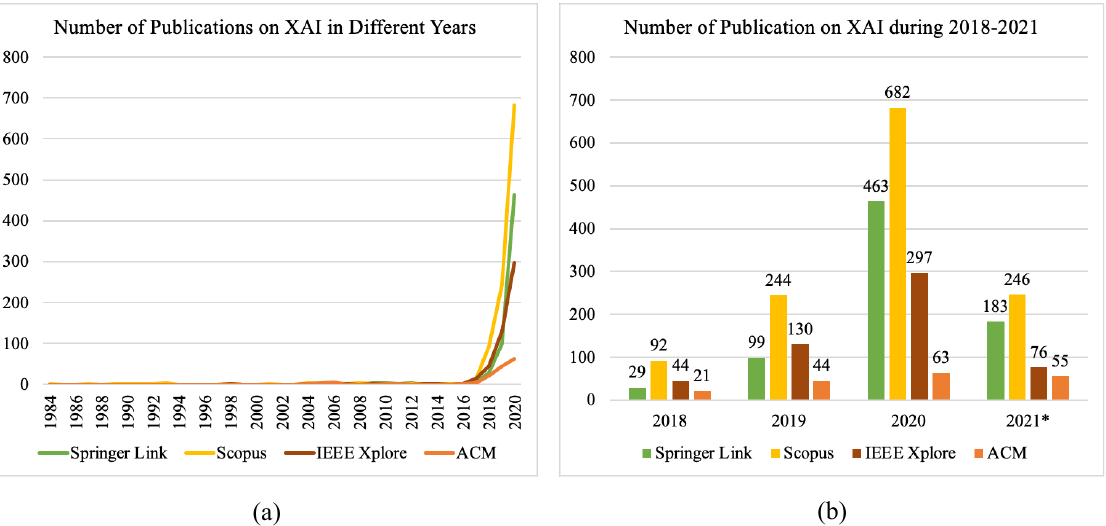
Figure 1. Number of published articles (y axis) on XAI made available through four bibliographic databases in recent decades (x axis): ( a ) Trend of the number of publications from 1984 to 2020. ( b ) Specific number of publications from 2018 to June 2021. The illustrated data were extracted on 1 July 2021 from four renowned bibliographic databases. The asterisk (*) with 2021 refers to the partial data on the number of publications on XAI until